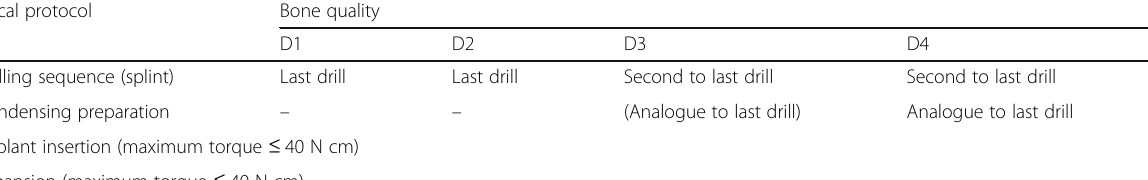
Table 2 Surgical treatment protocol Surgical